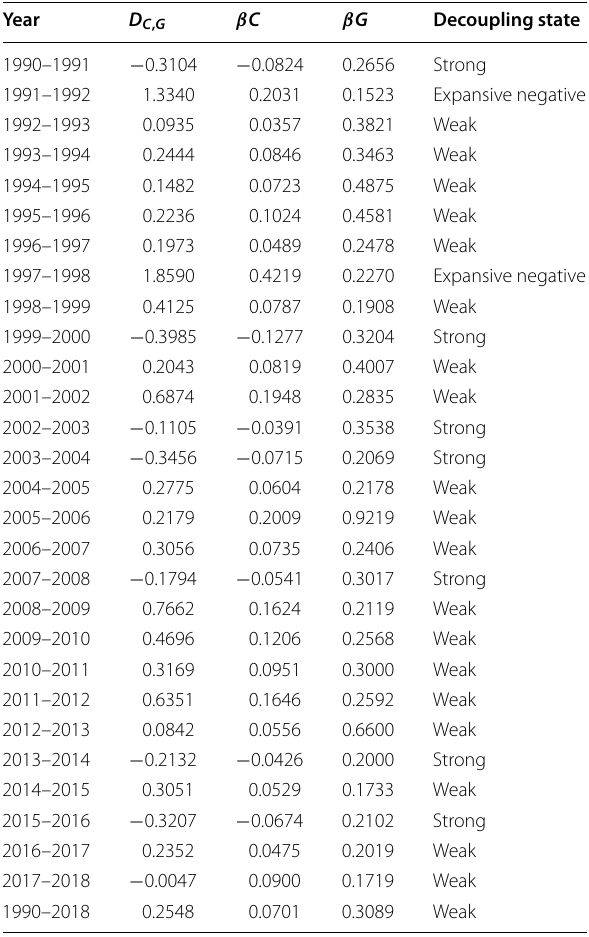
emissions from 2